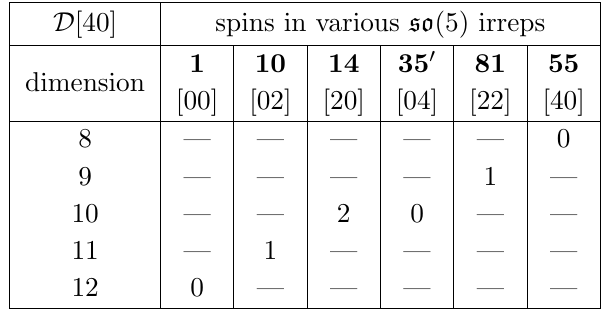
Table 4 . All possible conformal primaries in D [20] (cid:2) D [20] corresponding to the D [40] supercon- formal